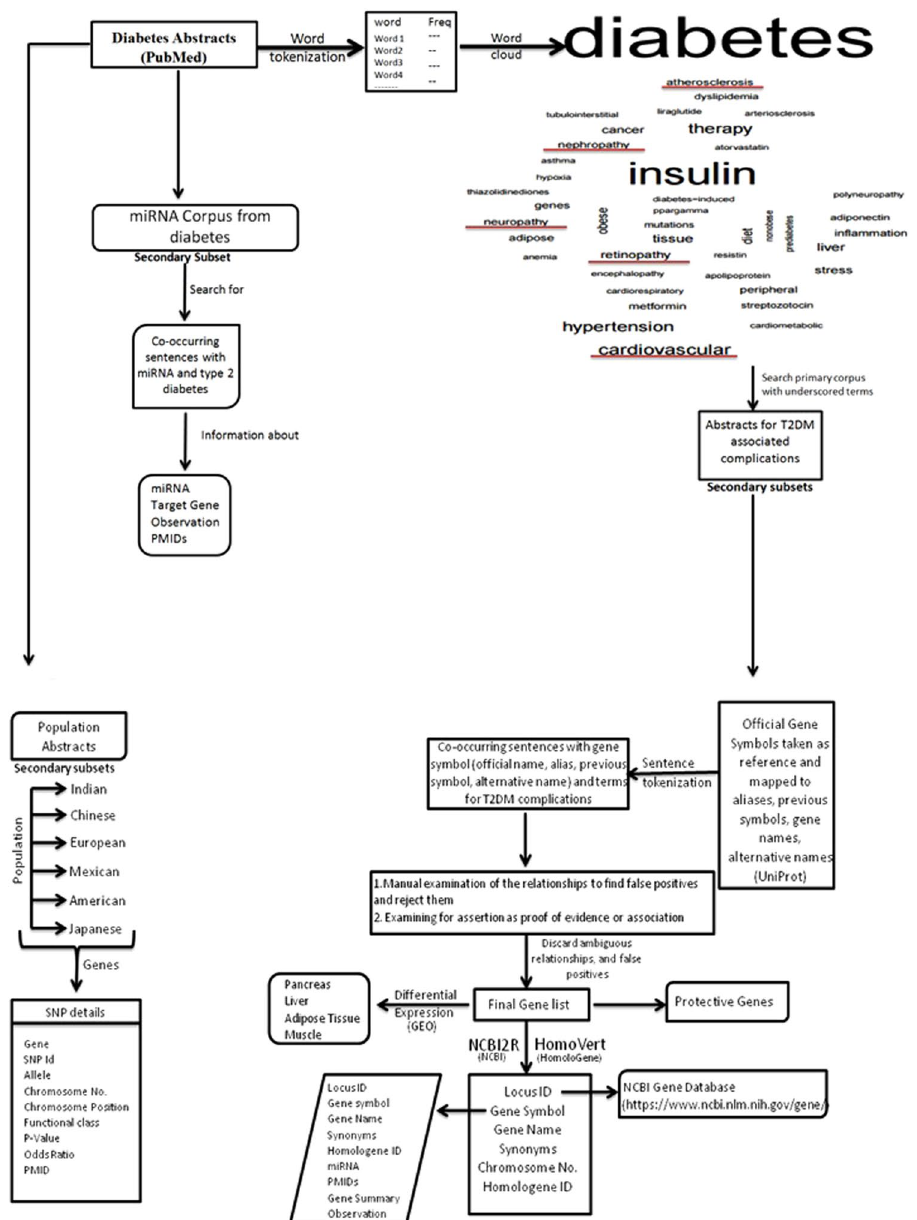
Figure 1. Work flow for text analytics of literature from PubMed. The data sources for each task are mentioned adjacent to the task